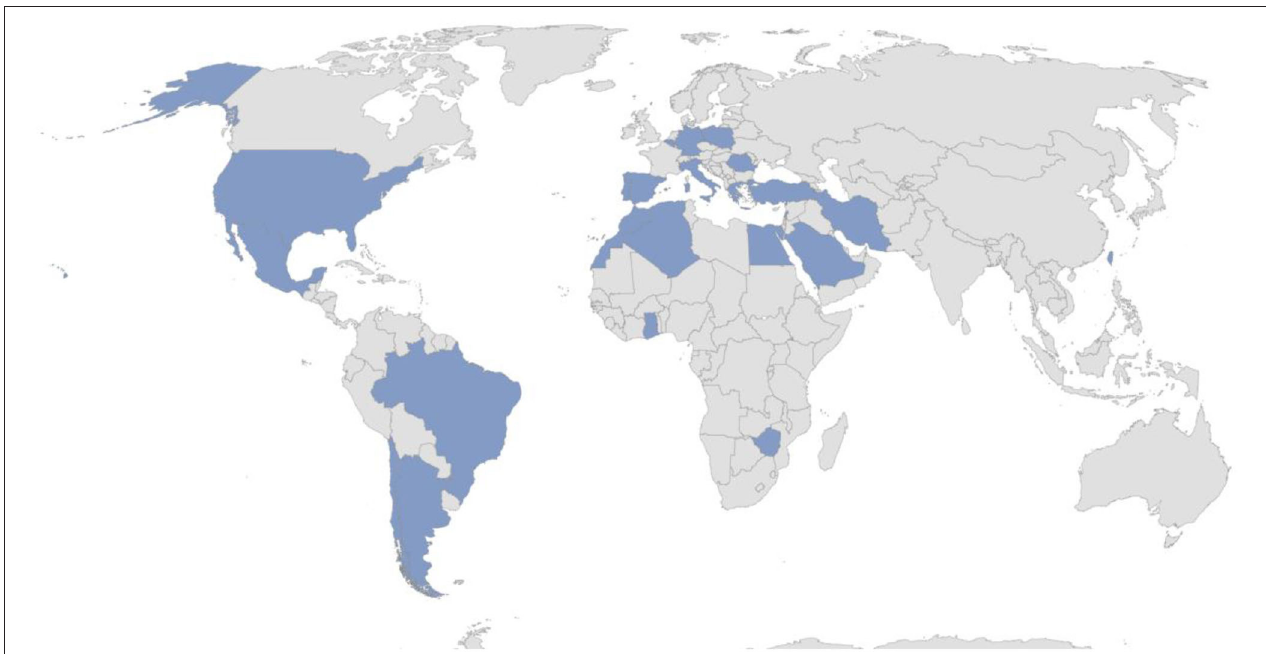
FIGURE 2 | Country involved in the AIDA Network (update February 7 th ,